Question: What form of chart is displayed?
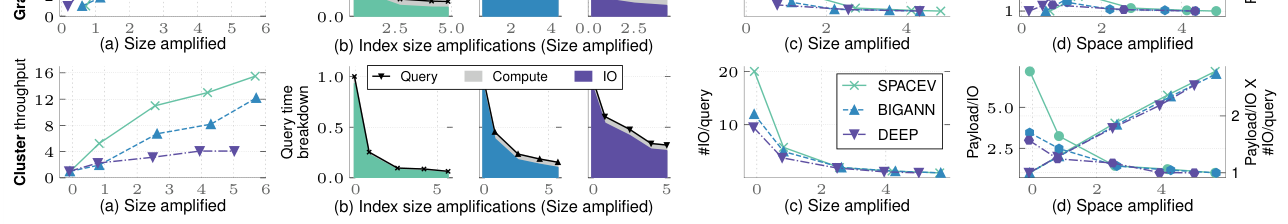
Answer: line